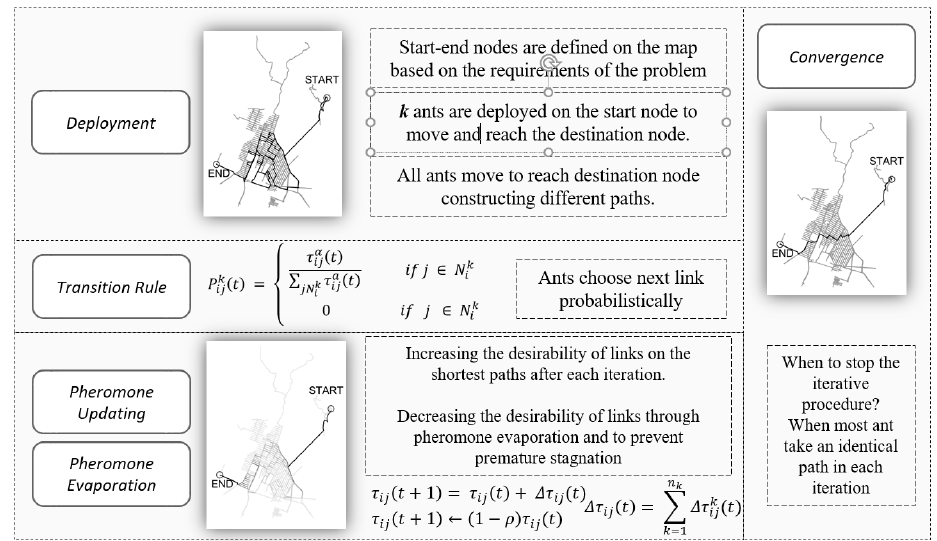
Figure 1. Ant colony optimization entities and procedures.